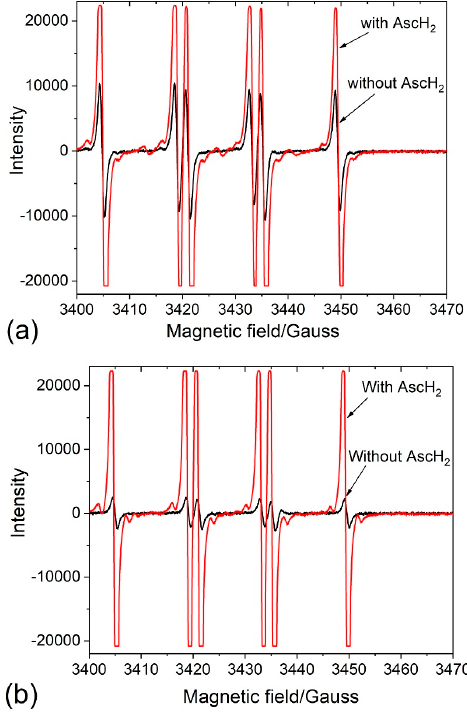
Figure 4. EPR spectra of TMIO–OH spin adduct in the absence (black) and presence (red) of ascorbic acid ( a ) without L1 and ( b ) in the presence of 3 mM L1. Experiments were performed at room temperature in distilled water at pH = 3.3; reaction mixture: 20 mM TMIO; 3 mM FeCl 3 ; 12 mM H 2 O 2 ; 10 mM ascorbic acid. However, the situation changed with an increase in the concentration of ascorbic acid from 10 to 100 mM in the reaction mixture. The observed amount of TMIO–OH spin adduct decreased in the presence of ascorbic acid in solution when the concentration ratios of L1:Fe = 2:1 or 4:1 were used (Figures 5 and 6). Although the optical study shows slow decay of the FeL1 3 complex in the presence of ascorbic acid in a weak acidic solution (see Figure 2c), we can assume the competition in the trapping of the hydroxyl radical by spin trap and ascorbic acid. An additional factor that can affect the intensity of the spin adduct signal is the transformation of the spin adduct to the corresponding hydroxylamine in acidic media. Due to its diamagnetic nature, hydroxylamine is an EPR silent compound. This process becomes important when the rate of hydroxyl radical production decreases due to chelate complexes FeL1 2 Asc or FeL1 3 formation.